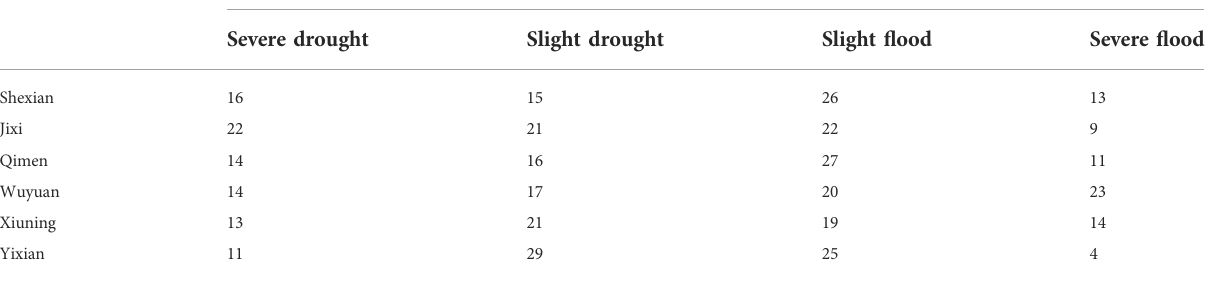
TABLE 3 Frequencies of different grades of fl oods and droughts in different counties in the Huizhou region during the Ming and Qing dynasties. County Grades of fl ood and drought Severe drought Slight drought Slight fl ood Severe fl ood Shexian 16